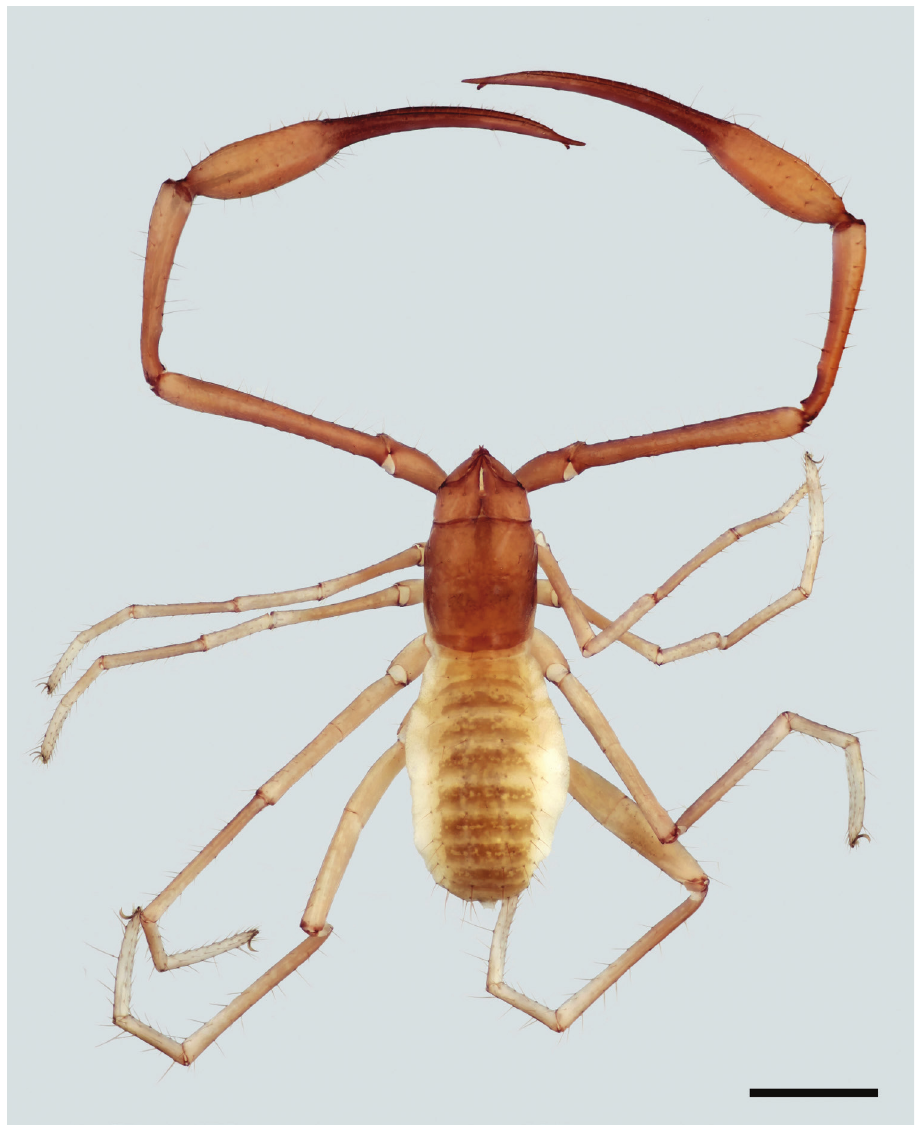
Figure 3. Male of Neobisium slovacum from Hačavská cave. Scale line: 1 prominent, rounded, with strong denticles; palpal trochanter without tubercles; palpal femur ratio in the range 5.69–8.81 mm; fixed palpal finger with unequally long teeth; telotarsus IV with 2 long tactile setae. Chromosomes of male 2n = 69. Type locality. Slovakia, Slovak Karst, Stará brzotínska cave (48°36'32"N; 20°28'15"E, 258 m a.s.l., length 120 m). Holotype. Adult of undetermined sex collected from stony debris on clay sedi- ment on 26 September 1974. Apparently lost.